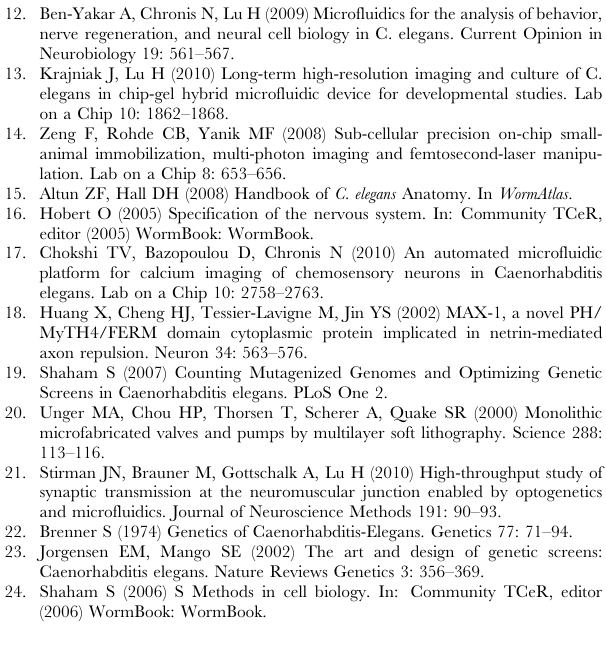
Figure S1 Proportion of adult animals in a population with at least one incidence of each independent defect (%). Figure S2 Proportion of L1 animals in a population with at least one incidence of each independent defect (%). Figure S3 Penetrance of defects per cell in L1 populations with at least one incidence of each independent defect (%).